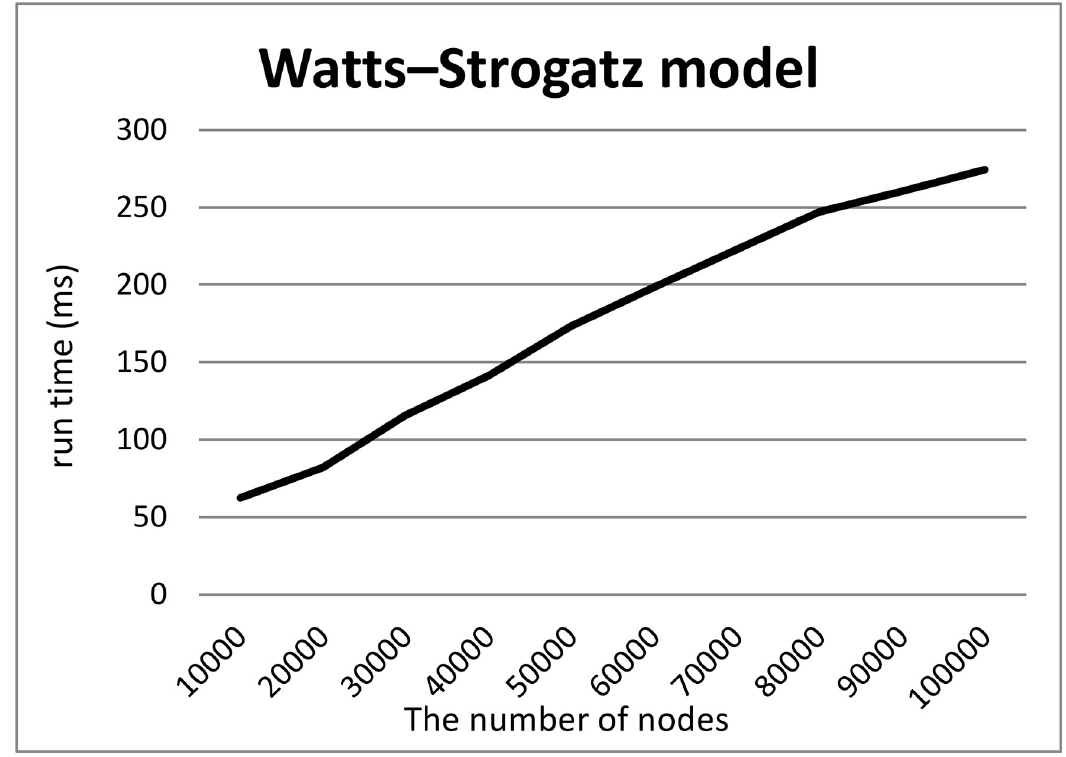
Fig 6. Computation time required to split the dataset generated using the Watts–Strogatz model. x -axis and y -axis correspond to the number of nodes and the average of running time [ms].